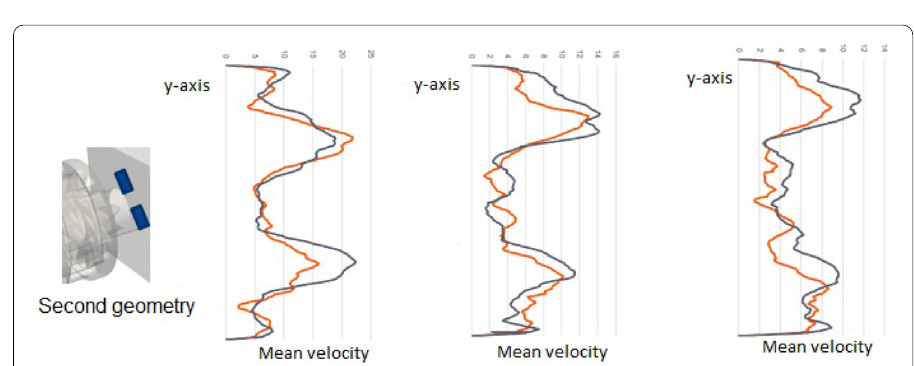
Fig. 57 G2: comparison of the recirculation zones obtained respectively as a consequence of the classical Gappy-POD in red and the HF LES in black